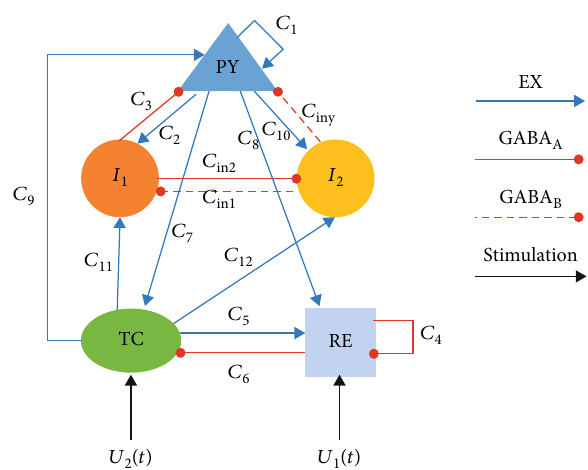
Figure 1: The topological structure of the model, which is composed of excitatory pyramidal neuronal (PY), inhibitory interneuron with di ff erent time scales ( I 1 , I 2 ), thalamic relay nucleus (TC), and thalamic reticular nucleus (RE). The blue lines indicate the excitatory projection of glutamate receptors, while red solid lines and red dashed lines represent the inhibitory projection mediated by GABA and GABA , respectively. U 1 ð t Þ and U 2 ð t Þ A B are the stimulus on RE and